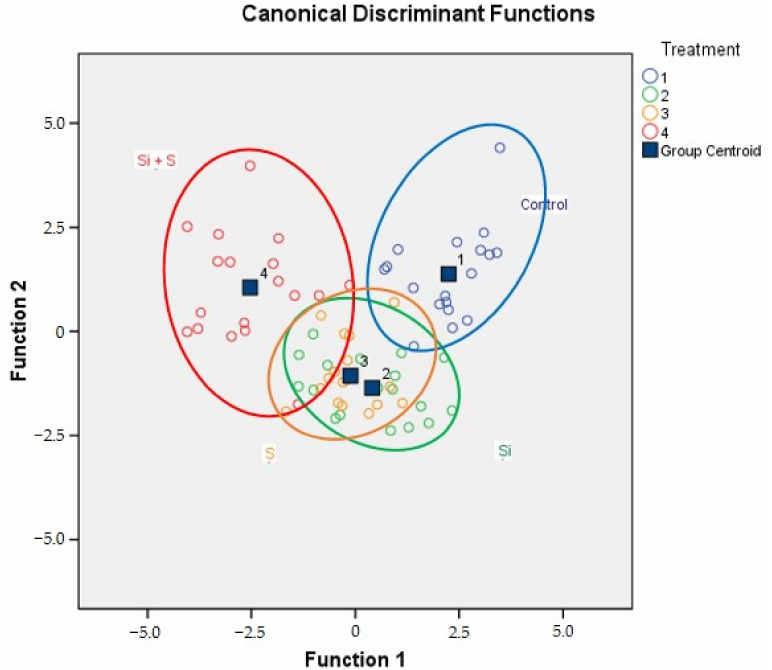
Figure 11. The combined groups plot of discriminant analysis for foliar fertiliser treatments (Debrecen, 2021). (Treatment 1: Control; Treatment 2: Si; Treatment 3: S; Treatment 4: Si +